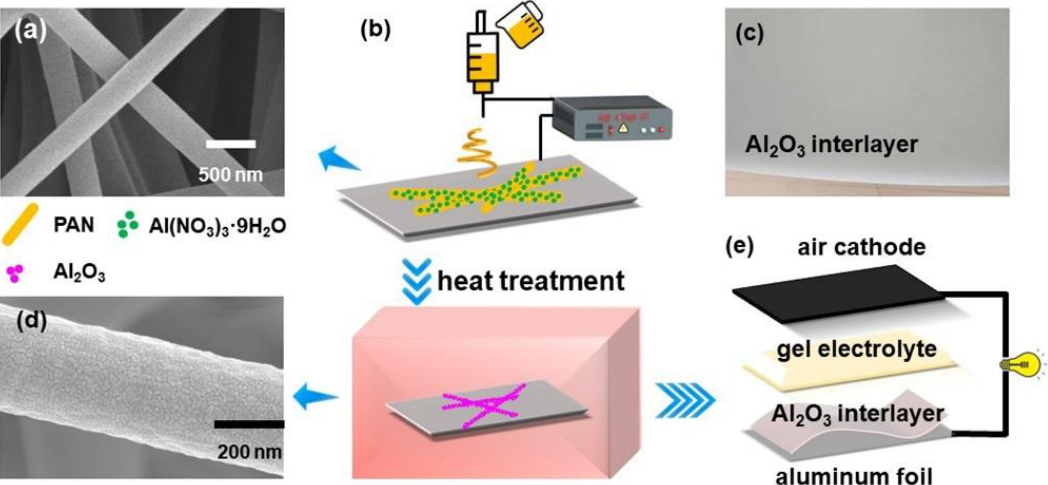
Figure 1. Scanning Electron Microscope (SEM) images of the electrospun nanofibers before ( a ) and after ( d ) heat treatment. ( b ) Schematic showing the fabrication process of the Al 2 O 3 interlayer. ( c ) The Al 2 O 3 interlayer fabricated by electrospinning. ( e ) Sandwich structure of the Al–air battery.